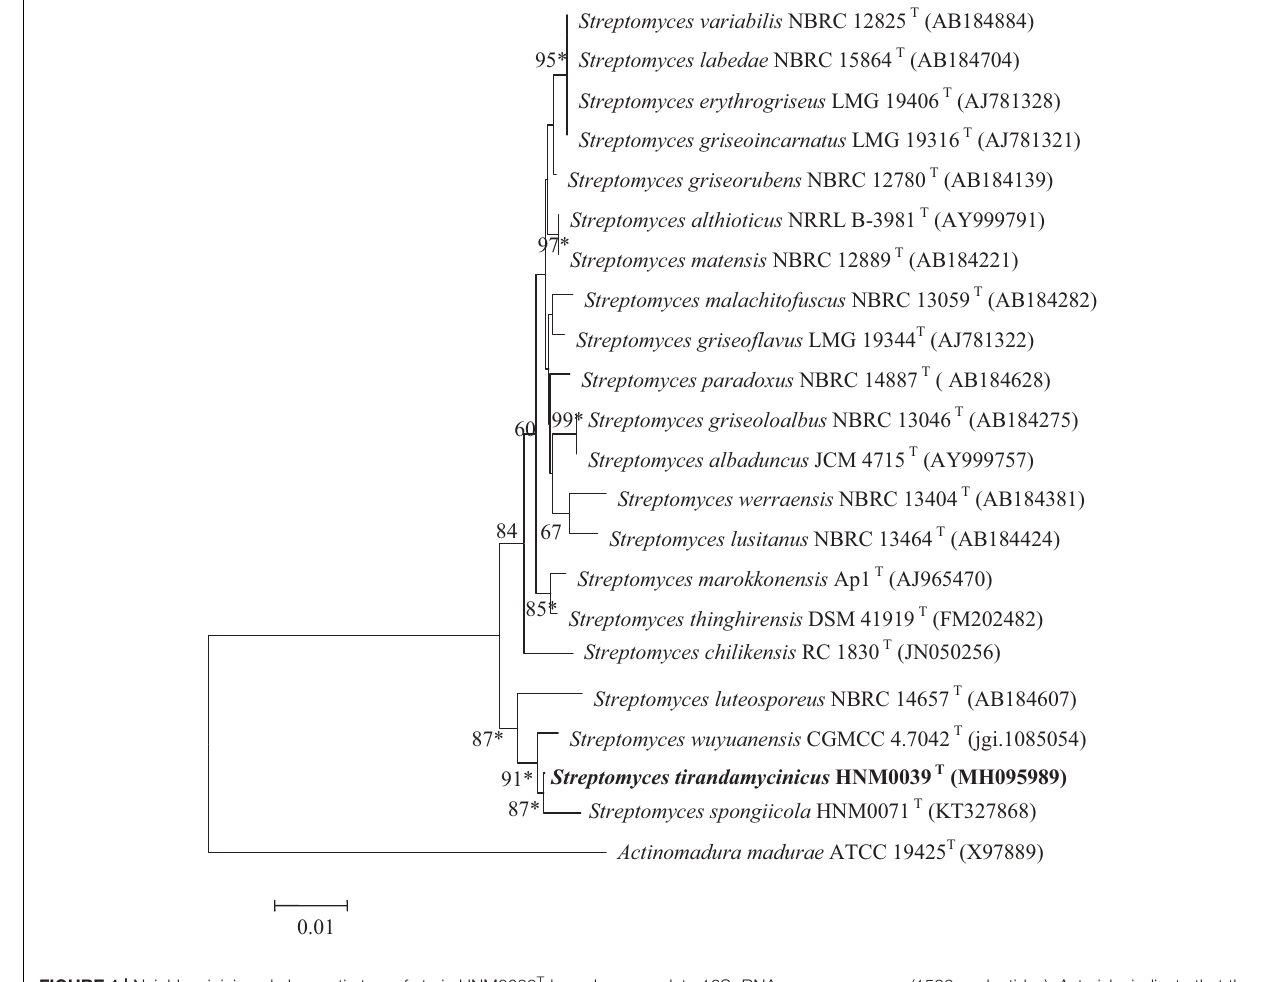
FIGURE 1 | Neighbor-joining phylogenetic tree of strain HNM0039 T based on complete 16S rRNA gene sequences (1523 nucleotides). Asterisks indicate that the conserved branches were also recovered using maximum-parsimony and maximum-likelihood tree-making algorithms. Bootstrap values based on 1000 replications are listed as percentages; only values > 50% are given. Bar: 0.01 substitutions per nucleotide